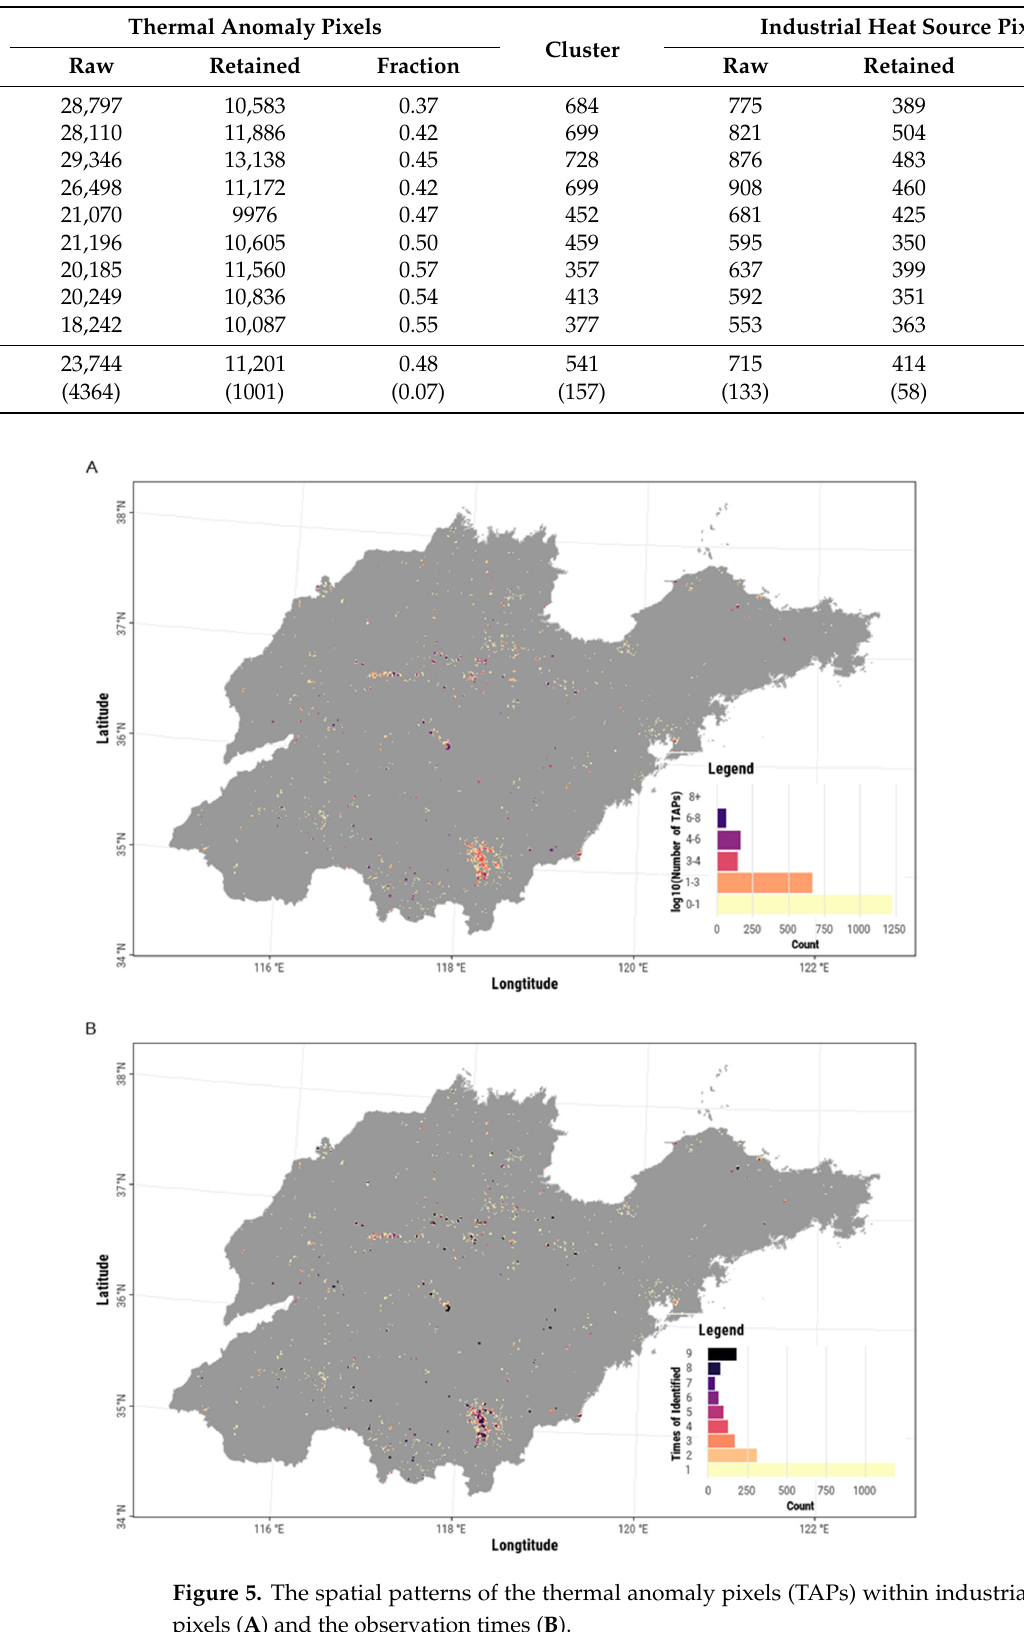
Table 2. Statistical variations in thermal anomaly pixels (TAPs), clusters, and industrial heat source (IHS) objects during processing.